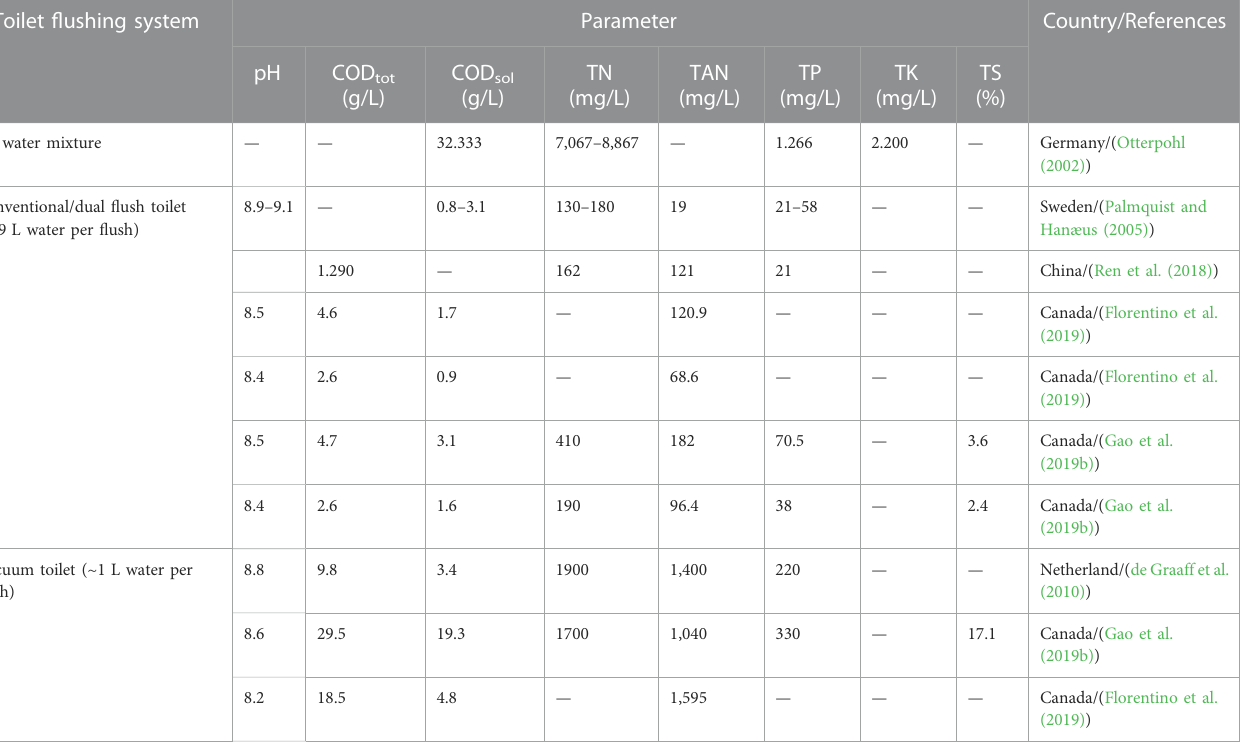
TABLE 3 Blackwater characteristics from different sewerage system. Toilet fl ushing